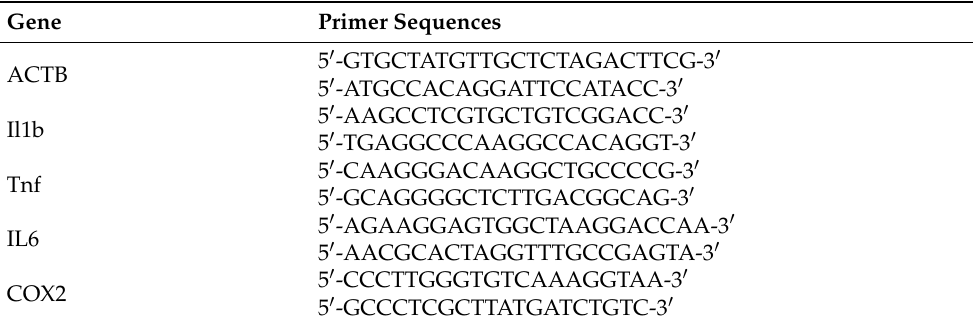
Table 1. List of primer sequences used for RT-PCR in this